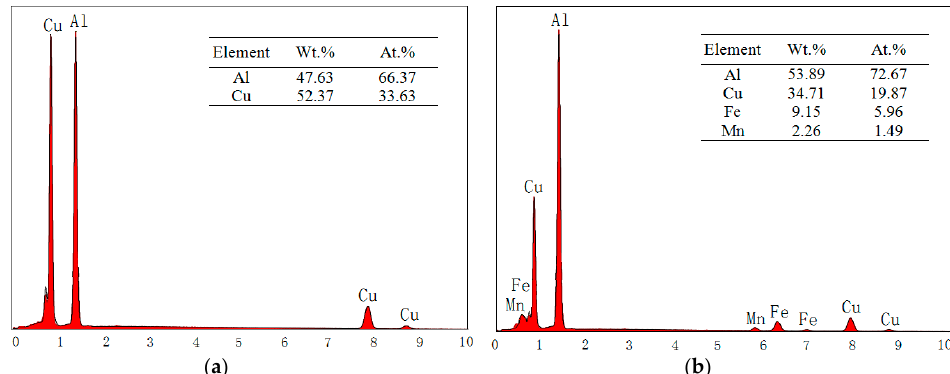
Figure 3. The second-phase particles component detected by energy dispersive spectrometer: ( a ) Point A and C (Al 2 Cu); ( b ) Point B (Al 7 Cu 2 (Fe, Mn)).